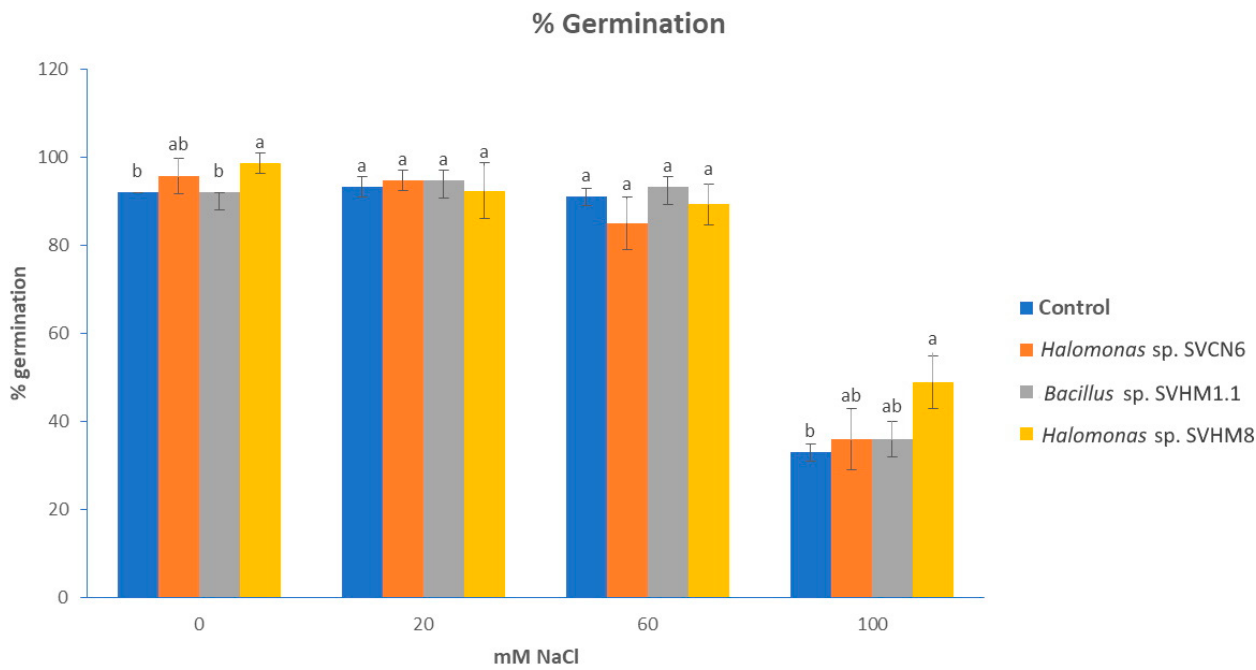
8 of 18 Figure 2. Heat map of the characteristics of plant growth promotion and enzymatic activity of bac- terial isolates associated with the root soil of S. verrucosum . Phosphate solubilization (Solub. PO 43 − ); Tryptophan-independent IAA production (Prod. IAA); Tryptophan-dependent IAA production (Prod. IAAt); Ammonium production from organic sources (Prod. NH 4+ ); Carbonate solubilization (Solub. CO 3 − ); Zinc solubilization (Solub. Zn + ); Sodium capture capacity (Capture of Na + ). The values of the scale range from − 4 to 4; values close to − 4 indicate no capacity and values close to 4 indicate high capacity for some of the corresponding characteristics. 2.6. Promotion of Plant Growth in Germination of Solanum lycopersicum under Saline Stress